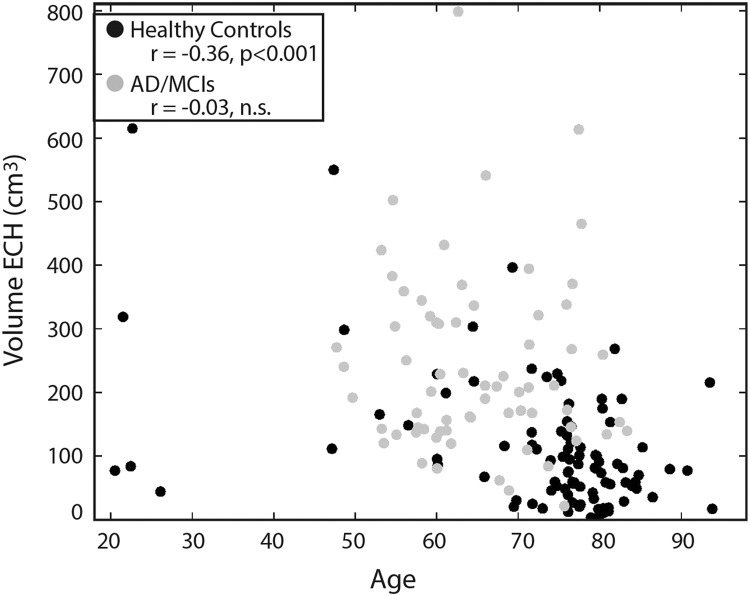
Age versus volume of ECH; Spearman correlation shows age is correlated with the volume of ECH in healthy controls but is not significant in the AD/MCI subgroup within that subsample.